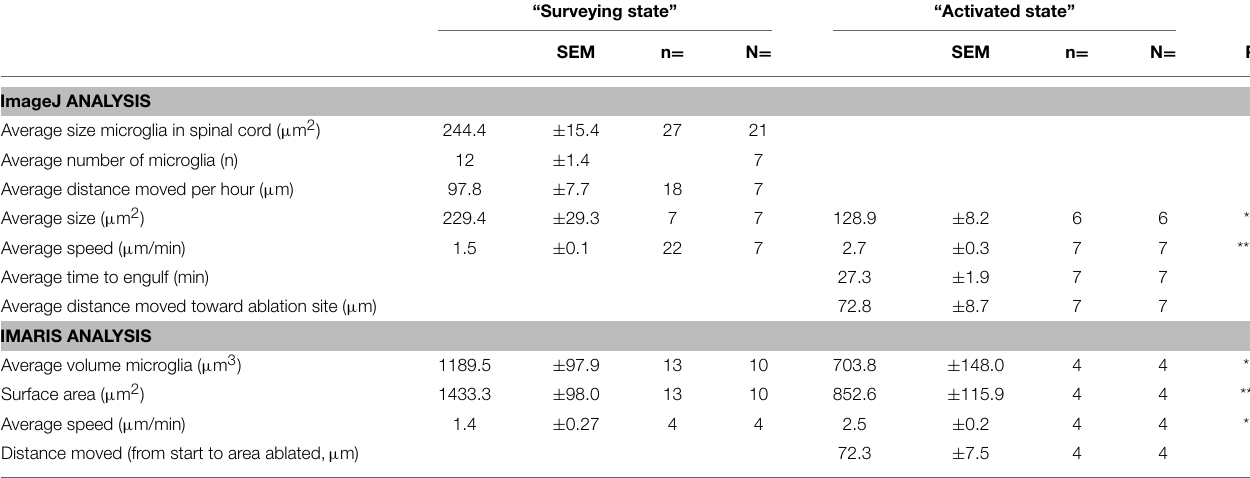
TABLE 1 | Morphometric characteristics of microglia before and after activation in response to UV-ablated spinal neurons. “Surveying state” “Activated state”